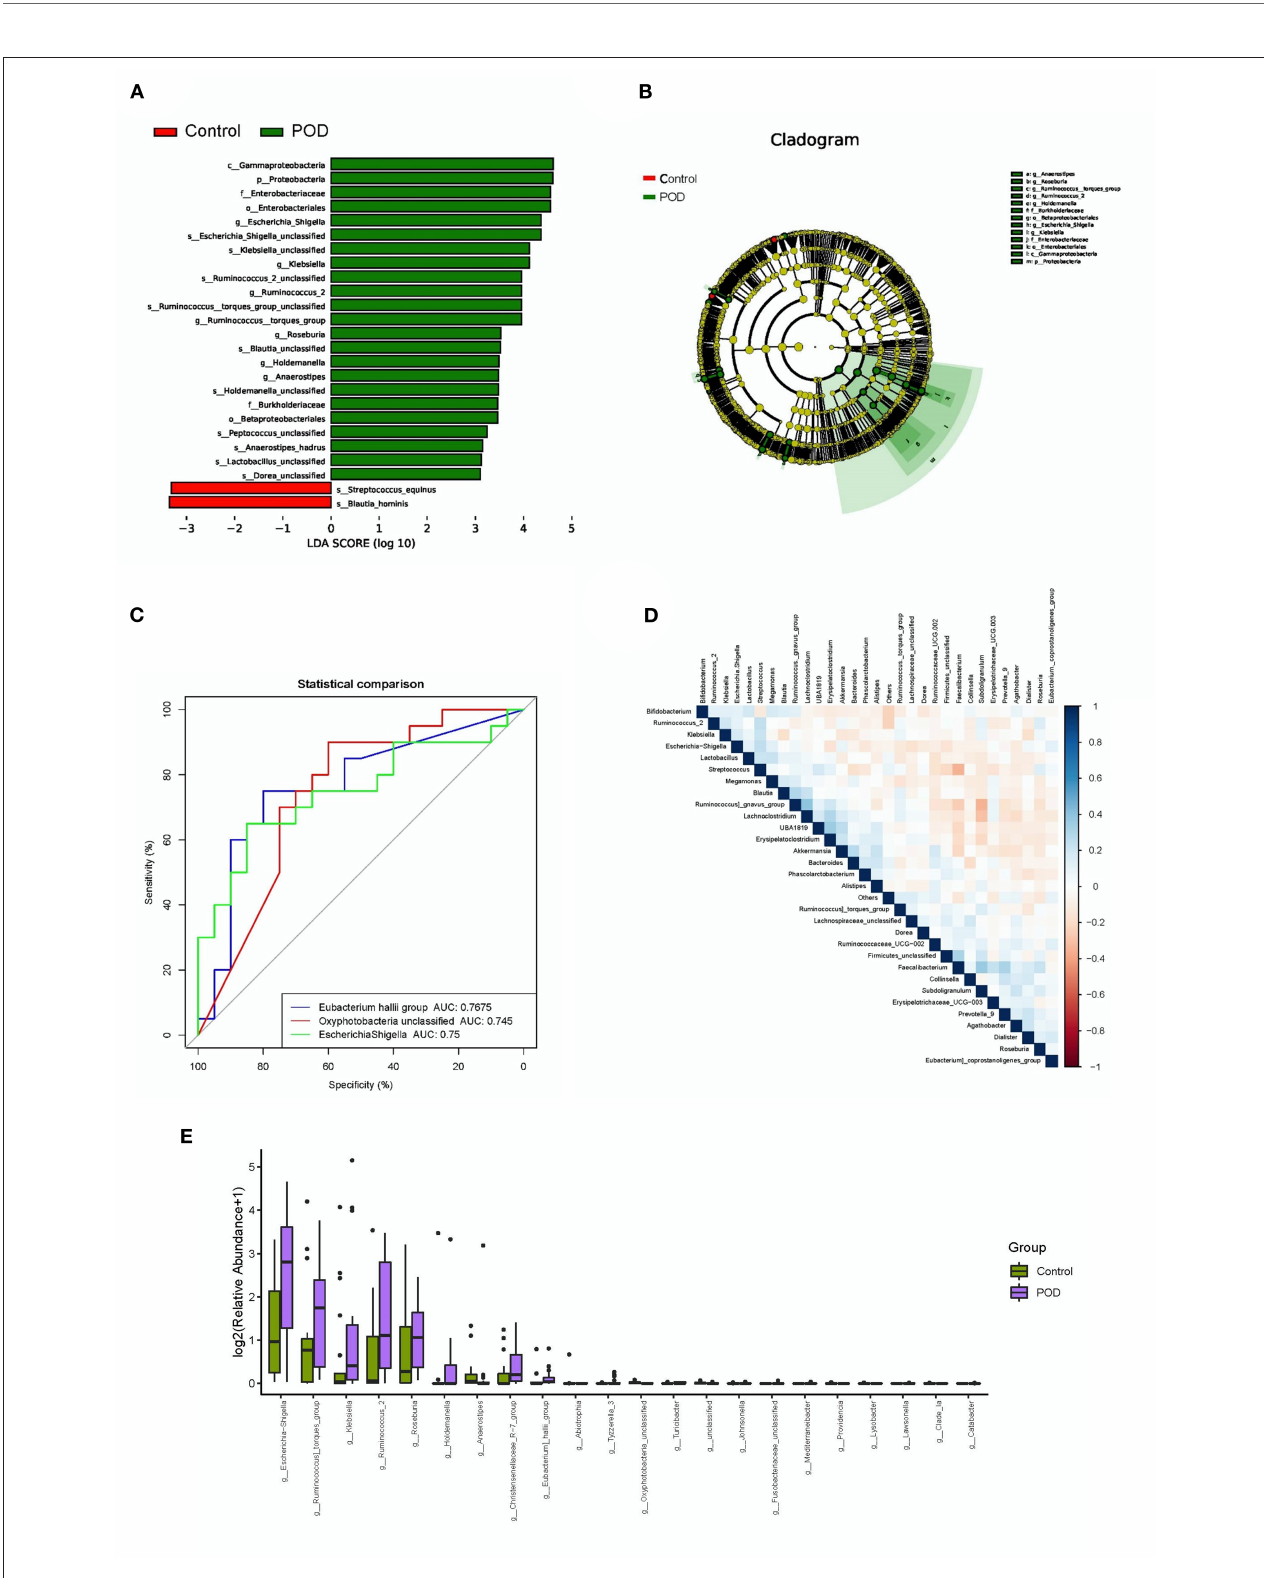
FIGURE 3 | Differential abundance and diagnostic efficacy of gut bacterial between POD and control cohorts. (A) Linear discriminant analysis effect size (LEfSe) of differentially abundant bacteria; (B) Cladogram of differentially abundant bacteria; (C) Receiver operating characteristic curve analysis of the diagnostic efficacies of bacteria (AUC > 0.7); (D) Correlation analysis among bacteria; (E) Differentially abundant bacteria in Genus level.